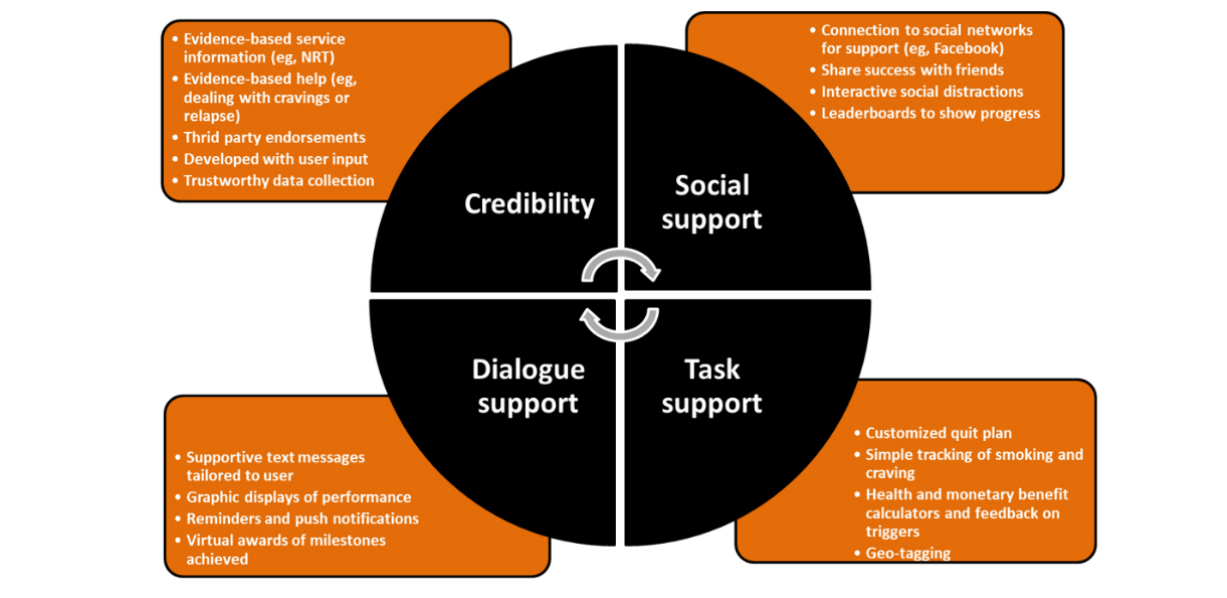
Figure 1. Crush the Crave design components. NRT: nicotine replacement